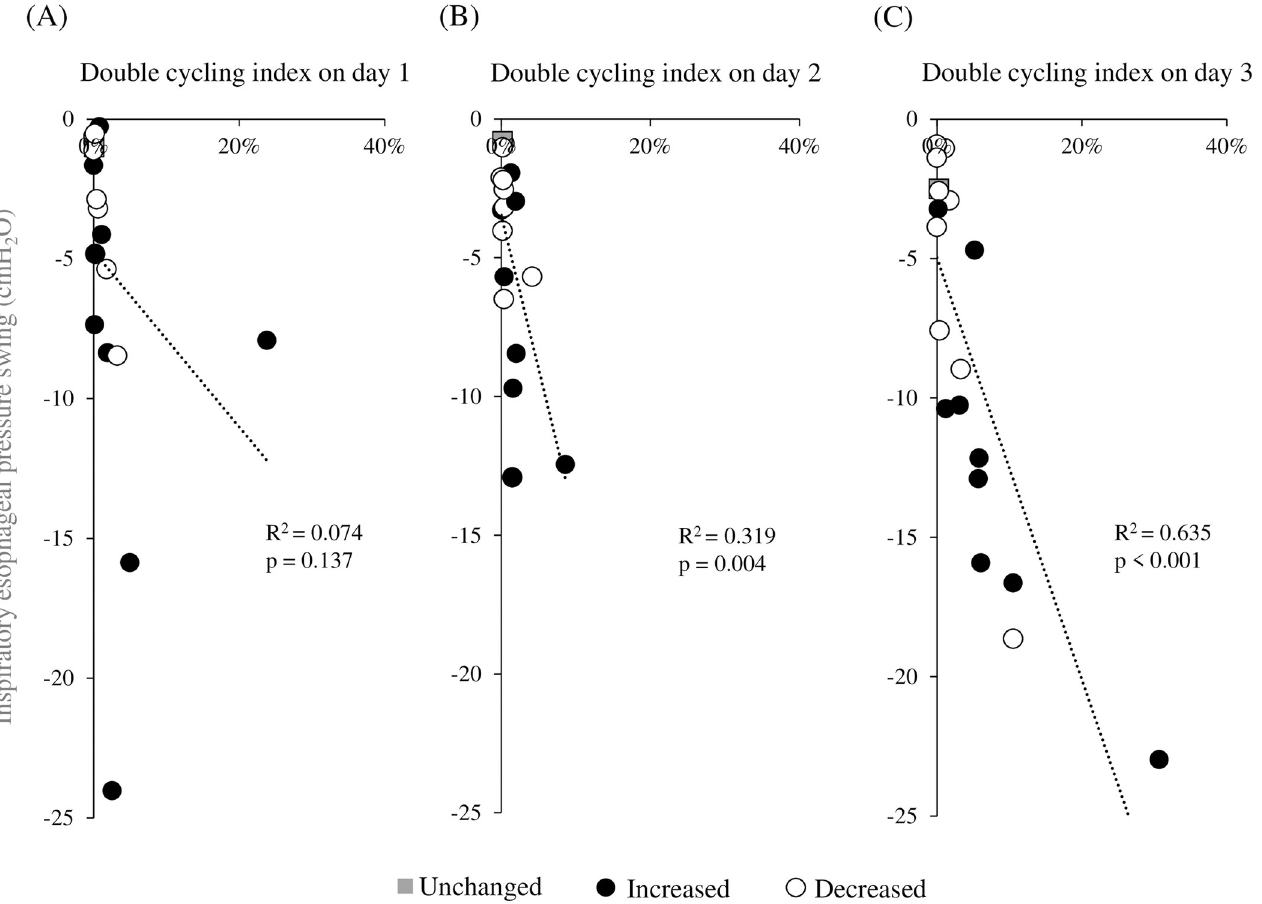
Fig 4. Correlation between the inspiratory esophageal pressure swing and the double cycling index on days 1 (A), 2 (B), and 3 (C).